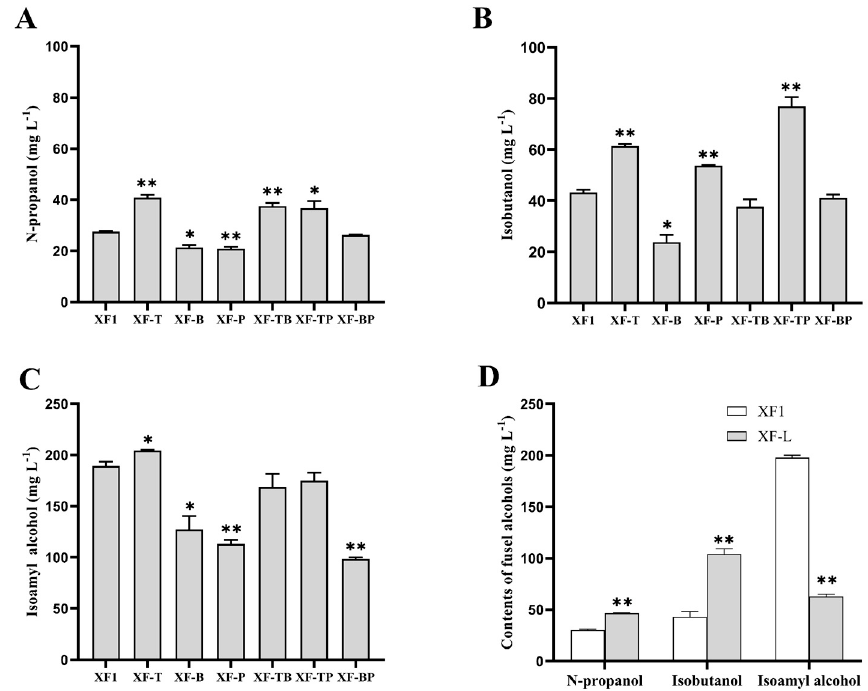
Figure 3. Contents of fusel alcohols produced by the recombinant strains and the wild-type strain XF1. ( A ) N-propanol content of recombinant strains and XF1. ( B ) Isobutanol content of recombinant strains and XF1. ( C ) Isoamyl alcohol content of recombinant strains and XF1. ( D ) Contents of fusel alcohols produced by recombinant strains XF-L and the wild-type strain XF1. The significant difference between the recombinant strains and XF1 was verified by Student’s t -test (* p < 0.05, ** p < 0.01).